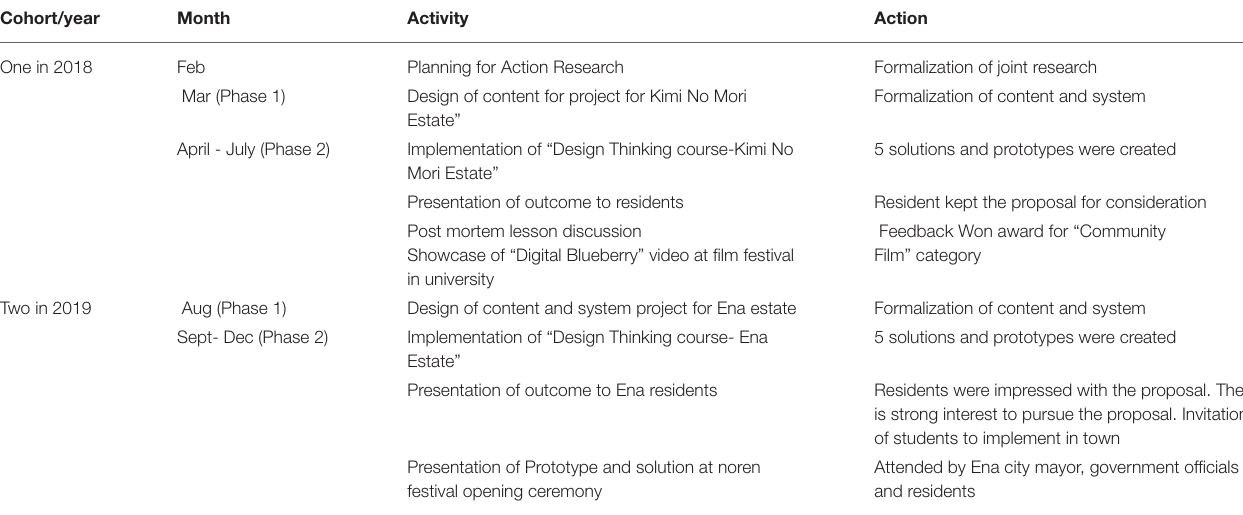
TABLE 2 | Timeline for employing design thinking in two suburban